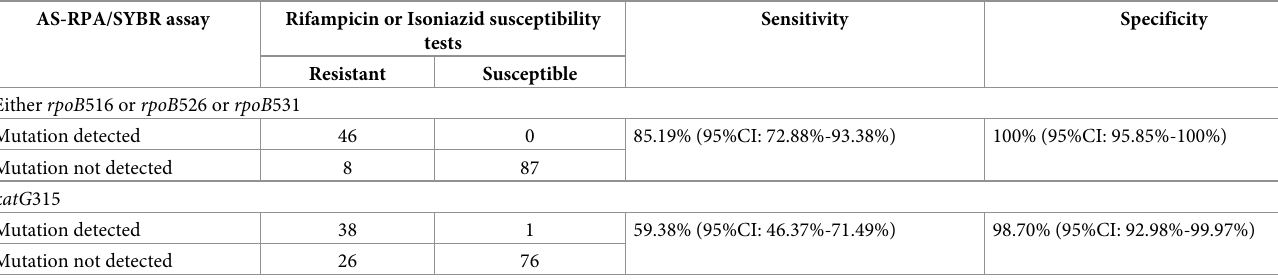
Table 7. Validation of AS-RPA/SYBR by a phenotypic drug susceptibility test (N = 141). AS-RPA/SYBR